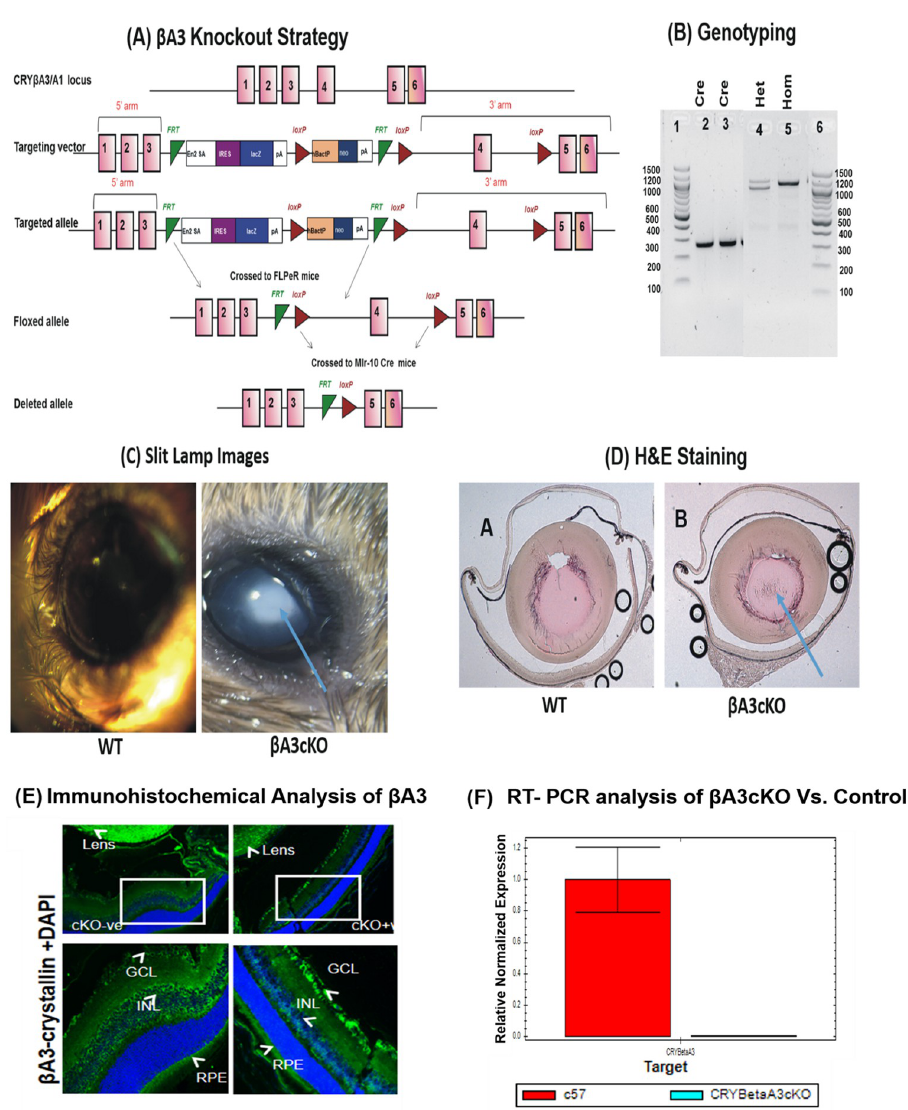
Fig 1. Generation and characterization of lens-specific β A3-crystallin conditional knockout mice. (A) Targeted strategy to generate β A3-crystallin conditional knockout mice ( β A3cKO). (B) β A3 mouse genotypic analysis of tail DNA: Lanes 1 and 6: DNA ladder, Lanes 2 and 3 represent presence of the MLR10 transgene, Lane 4: Flip heterozygous expression, and Lane 5: Flip homozygous expression. (C) Micron IV slit-lamp images of 1-month-old wild type lens showing a clear lens (left panel) whereas the β A3cKO mice (1-month-old) lens showing a dense nuclear cataract (identified with a blue arrow). (C) H&E-staining of 1-month-old wild type lens (left panel) and 1-month-old β A3cKO lens (right panel). Note the abnormal nuclear region in β A3cKO lens relative to wild type lens (shown by a blue arrow). (E) One month-old paraffin-embedded eye sections from wild type- and β A3cKO mice immune-stained with anti- β A3-crystallin antibody. The β A3cKO lens exhibited the lack of immunostaining of β A3-crystallin (upper right panel) but not in the wild type lens (upper left panel). The inset of WT lens (cKO-ve) and β A3cKO lens (cKO+ve) are further enlarged below in left and right panels, respectively. In β A3cKO lens (lower right panel), the expression of β A3-crystallin was unaffected in ganglion cells (GLC) and retinal pigment epithelial (RPE) cells and the immunostaining of these cells was comparable to the WT lens (lower left panel). (F) Quantitative-RT PCR analysis of β A3-expression in wild type- and β A3cKO lenses. Note no expression of β A3 in the β A3cKO lens relative to wild type lens. GAPDH was used to normalize the gene